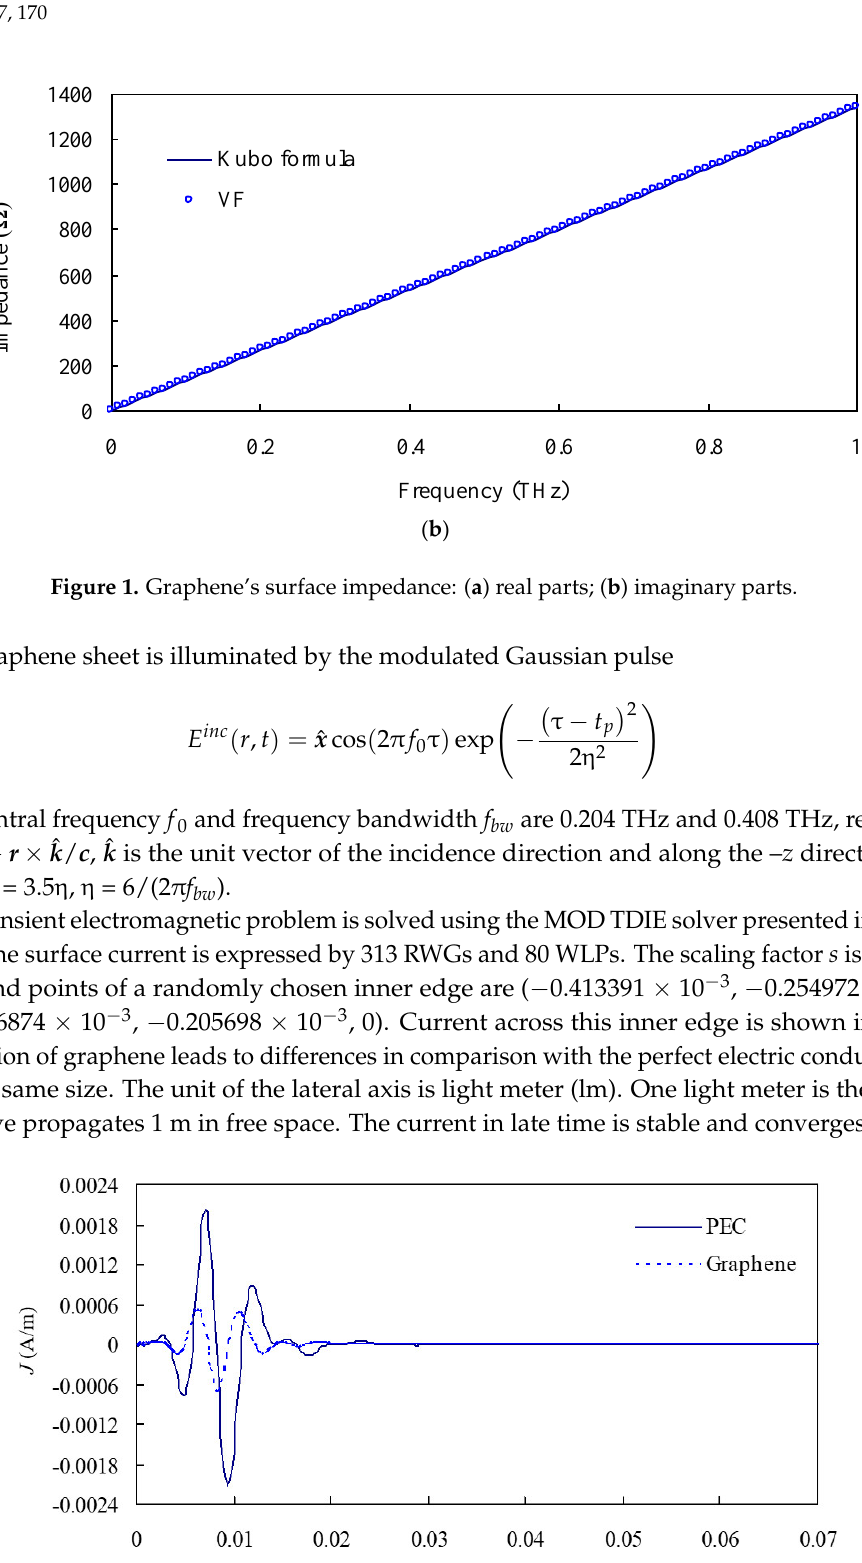
Figure 2. Induced current across a randomly chosen inner edge of the graphene sheet.